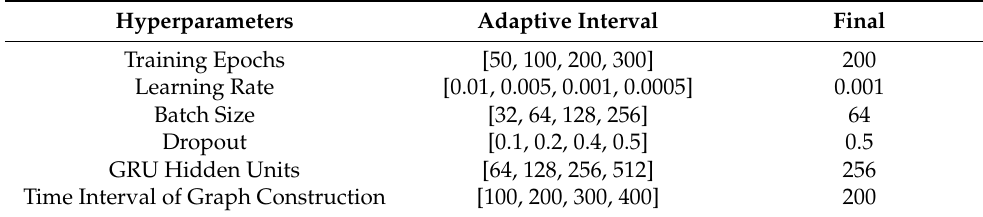
Table 6. Hyperparameters selections for